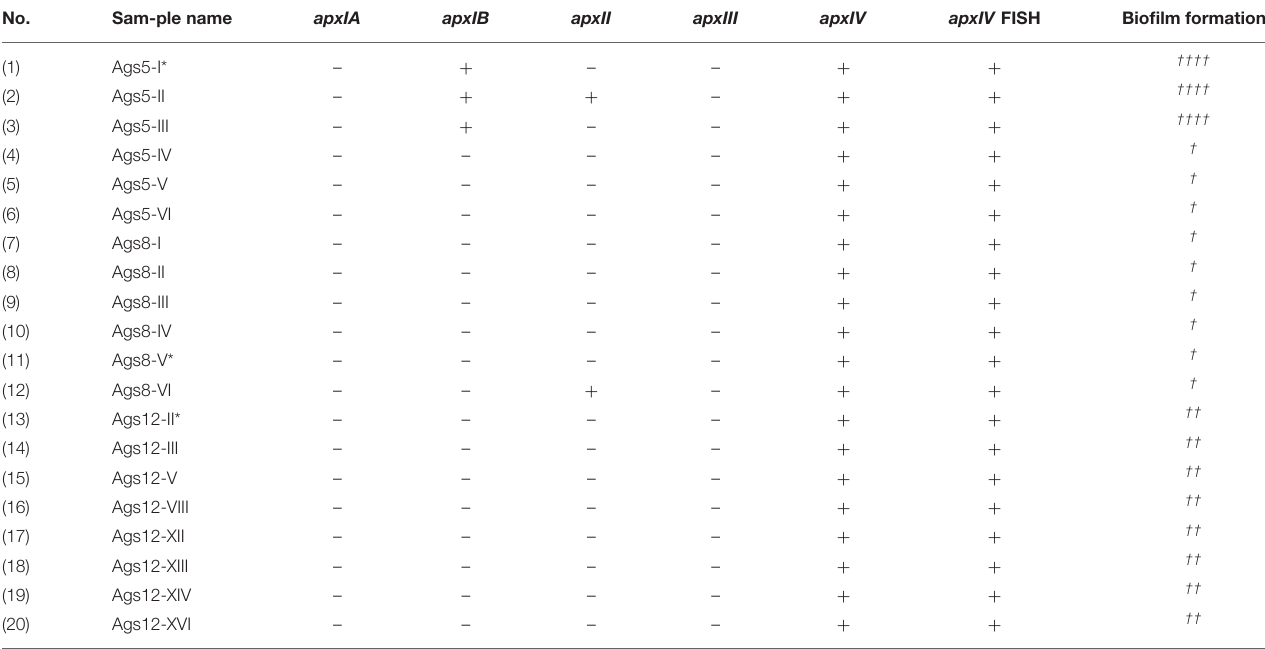
TABLE 2 | Properties of 20 positive samples of A. pleuropneumoniae from drinking water of swine farms in Mexico.